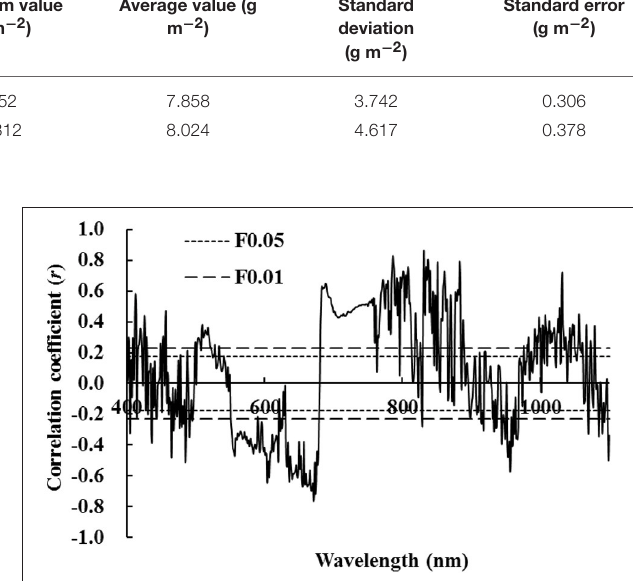
FIGURE 1 | Correlation coefficient between raw hyperspectral reflectance and wheat LNA (The correlation coefficient outside the two P 0.05 lines was significant at 0.05 level, while the correlation coefficient outside the two P 0.01 lines was significant at 0.01 level).